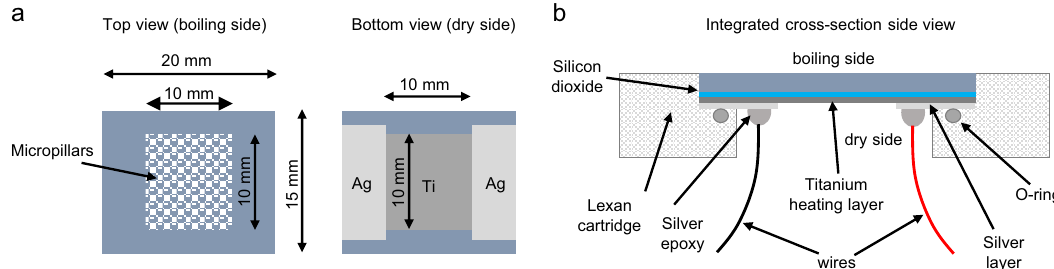
Fig. 6 Heated surface schematics (not to scale). a Top and bottom view of the silicon surface, with silver and titanium layers for heating. b Side view of the surface integrated in the Lexan support; the power wires are glued to the silver layer with conductive silver